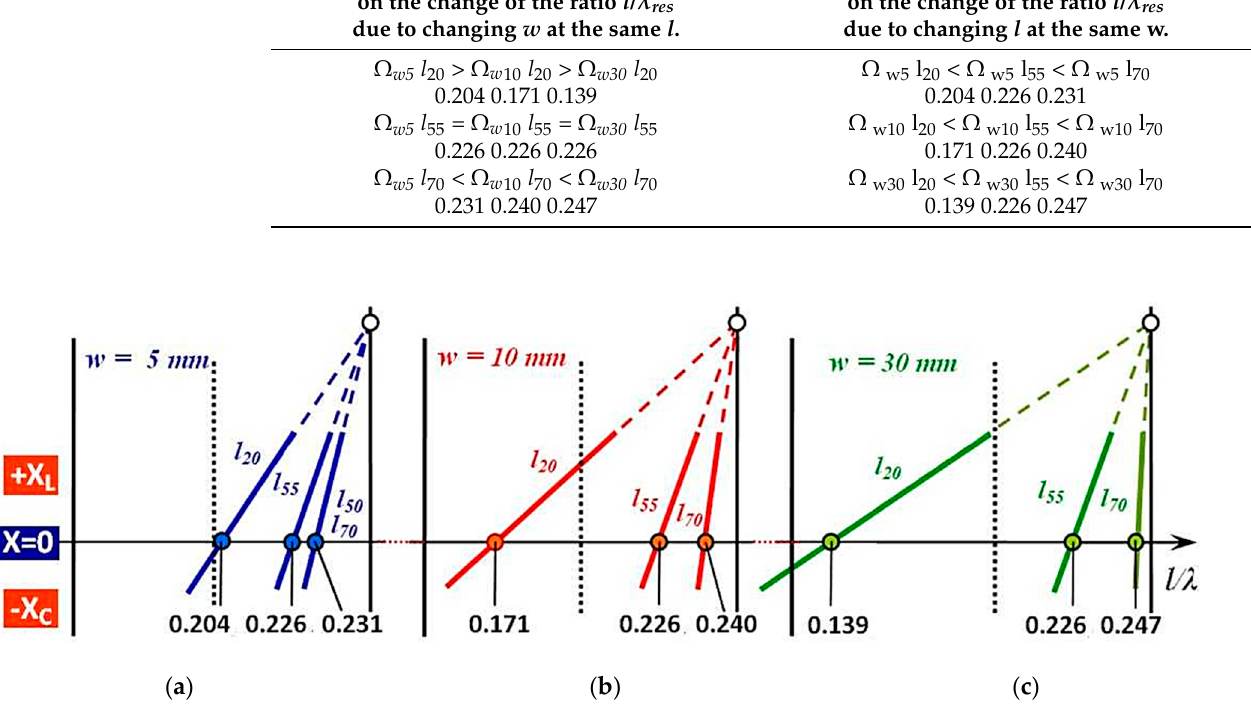
Influence of the change Ω of the flat antenna